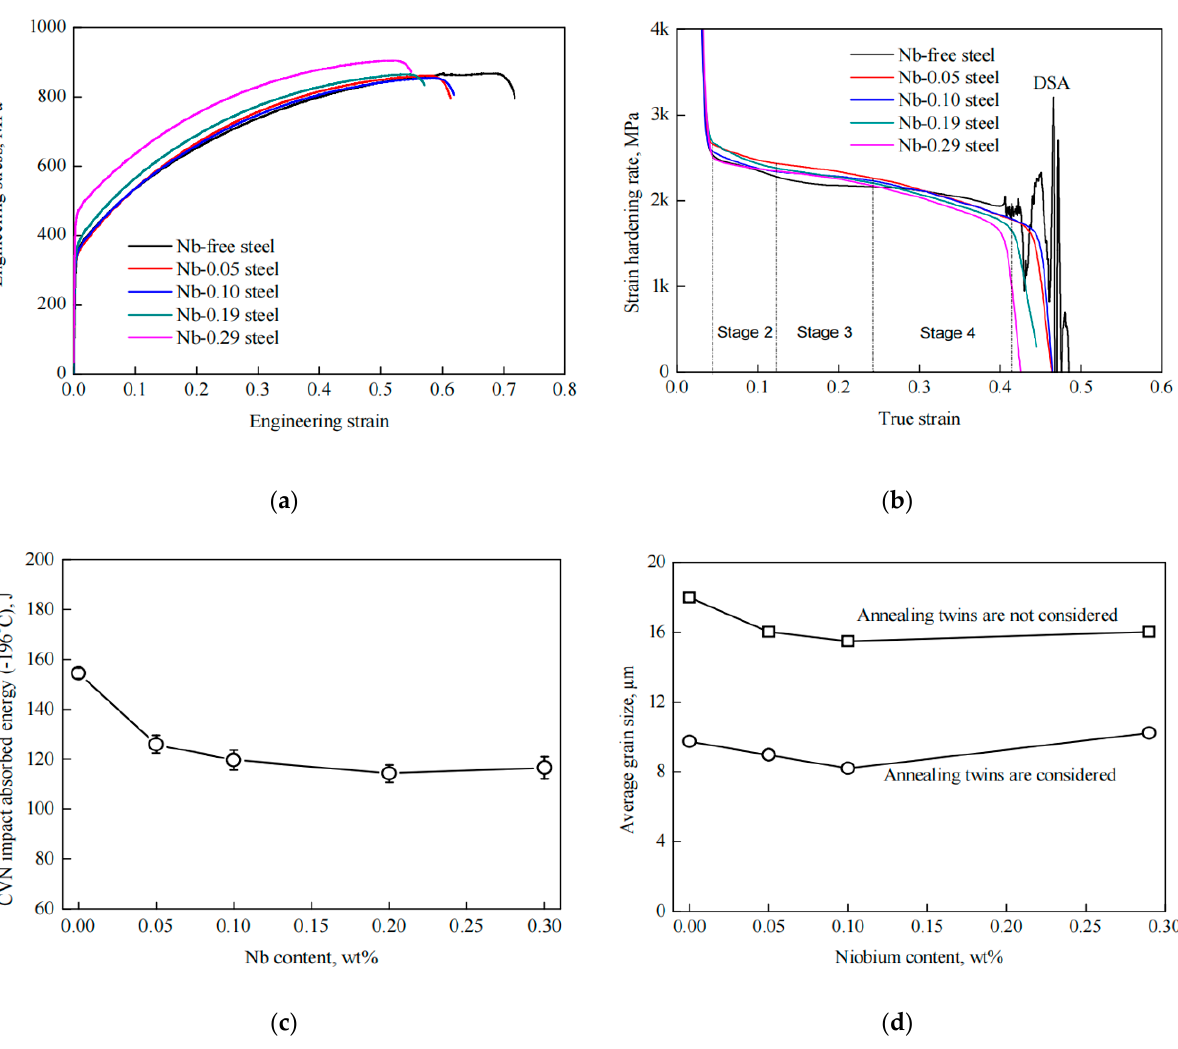
Figure 3. Effects of niobium contents on ( a ) engineering stress–strain curves, ( b ) corresponding strain-hardening curves, ( c ) Charpy V-notch impact absorbed energies at − 196 °C, and ( d ) grain sizes of high manganese steel (Reprinted with permission from Ref. [49] Copyright 2022 Elsevier).